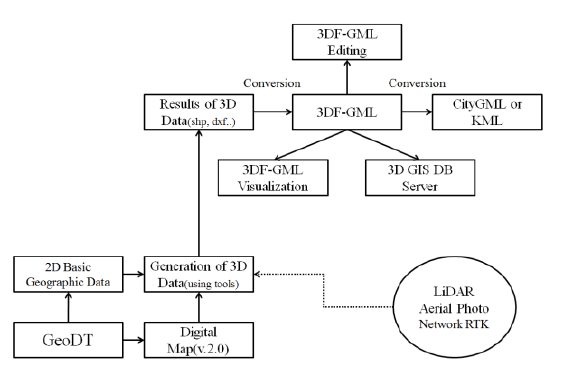
Figure 1. A Flowchart of the 3D Geospatial Data Generation and Conversion